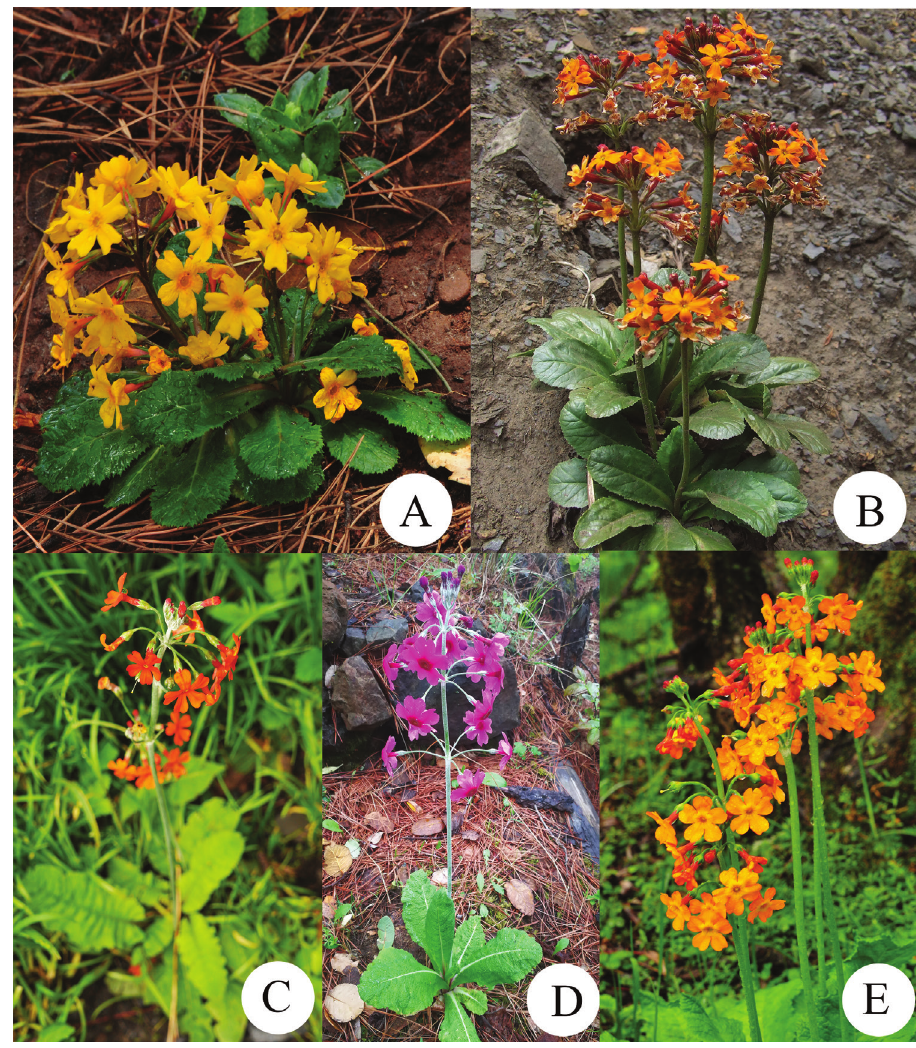
Figure 3. P. dongchuanensis and four of its close species A P. dongchuanensis B P. aurantiaca C P. cockbur- niana D P. chungensis E P. pulverulenta